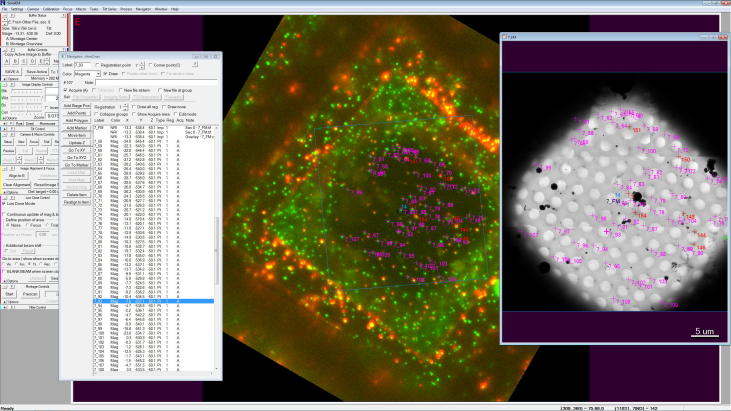
Screenshot: Setting up automated EM acquisition in SerialEM. The navigator window showing the coordinate list of all points and map images is seen in the foreground. The POI selected for acquisition are shown as pink crosses on top of both FM and EM maps. These have been aligned using the registration points shown in red. The positioning of the EM map on the right is indicated as the overlaid blue box on top of the FM map.